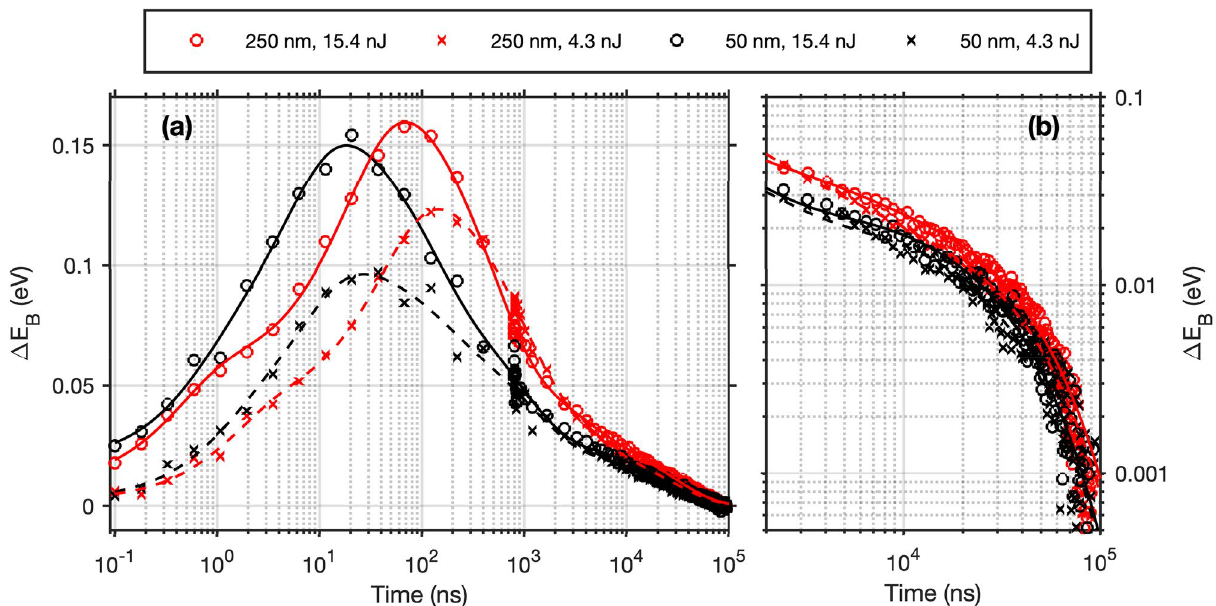
Figure 9. Kinetic traces obtained from delay scans on two PbS quantum dot samples with different thicknesses (250 nm, red and 50 nm, black) at two different laser pulse energies (15.4 nJ , circles and 4.3 nJ , crosses). Multi- exponential fits to the data are included as a guide to the eye. ( a ) Complete time range, ( b ) focus on longer times (> 2 µs) of the same delay scans with both axes on a logarithmic scale.